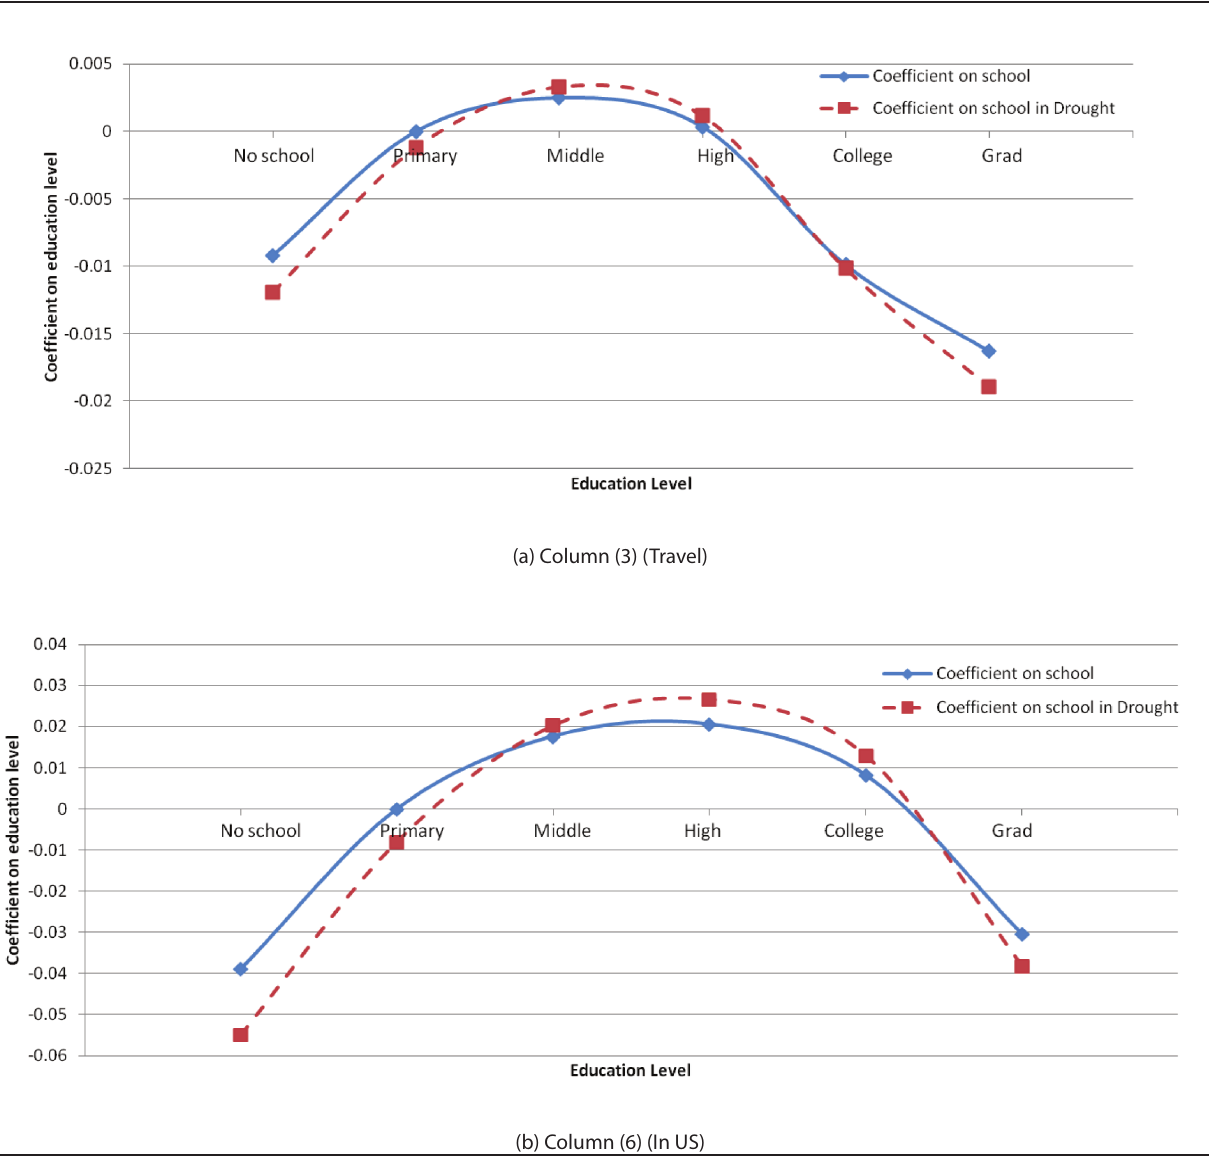
Figure 3 The relationship between educational attainments and migration probabilities changes with rainfall.